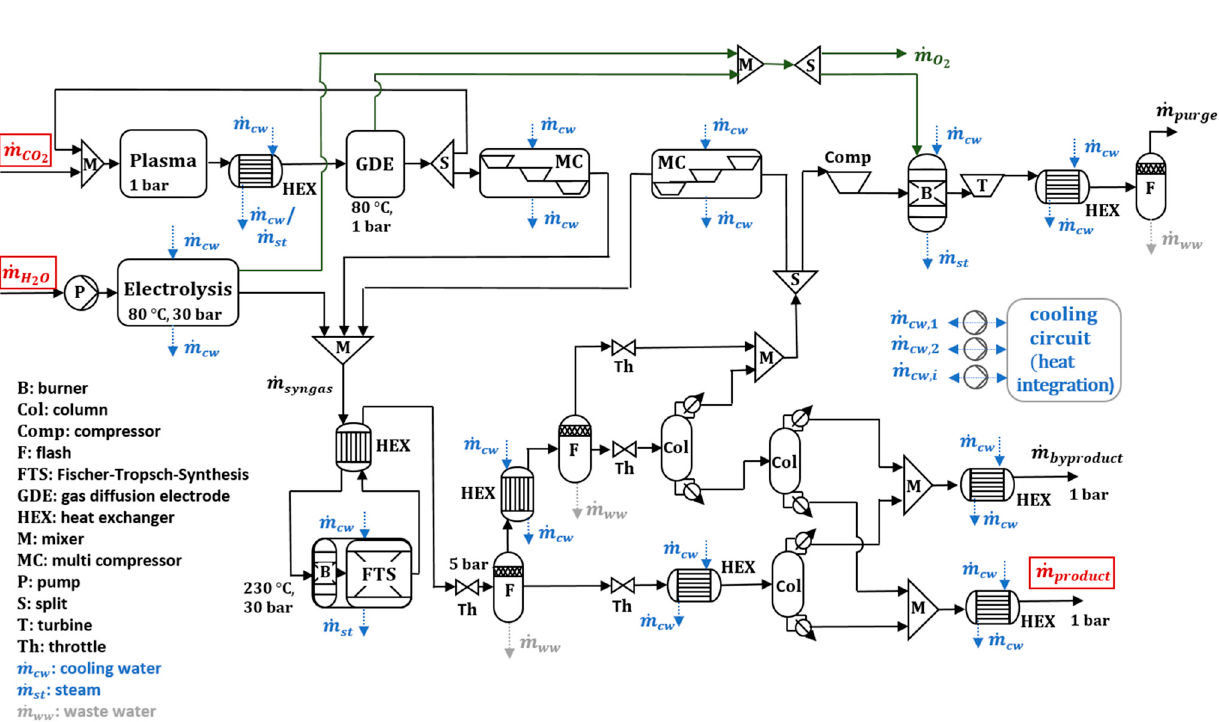
Figure A1. Flowsheet. Figure A1.